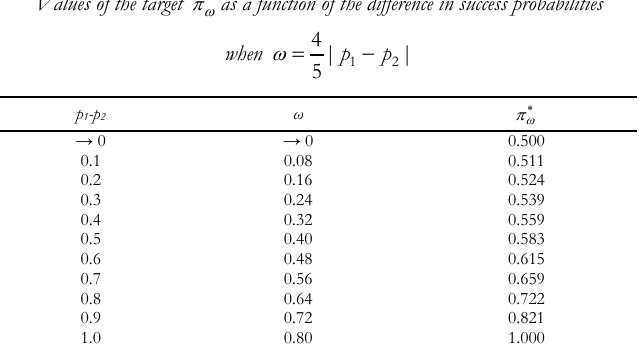
 as a function of the difference in success probabilities  